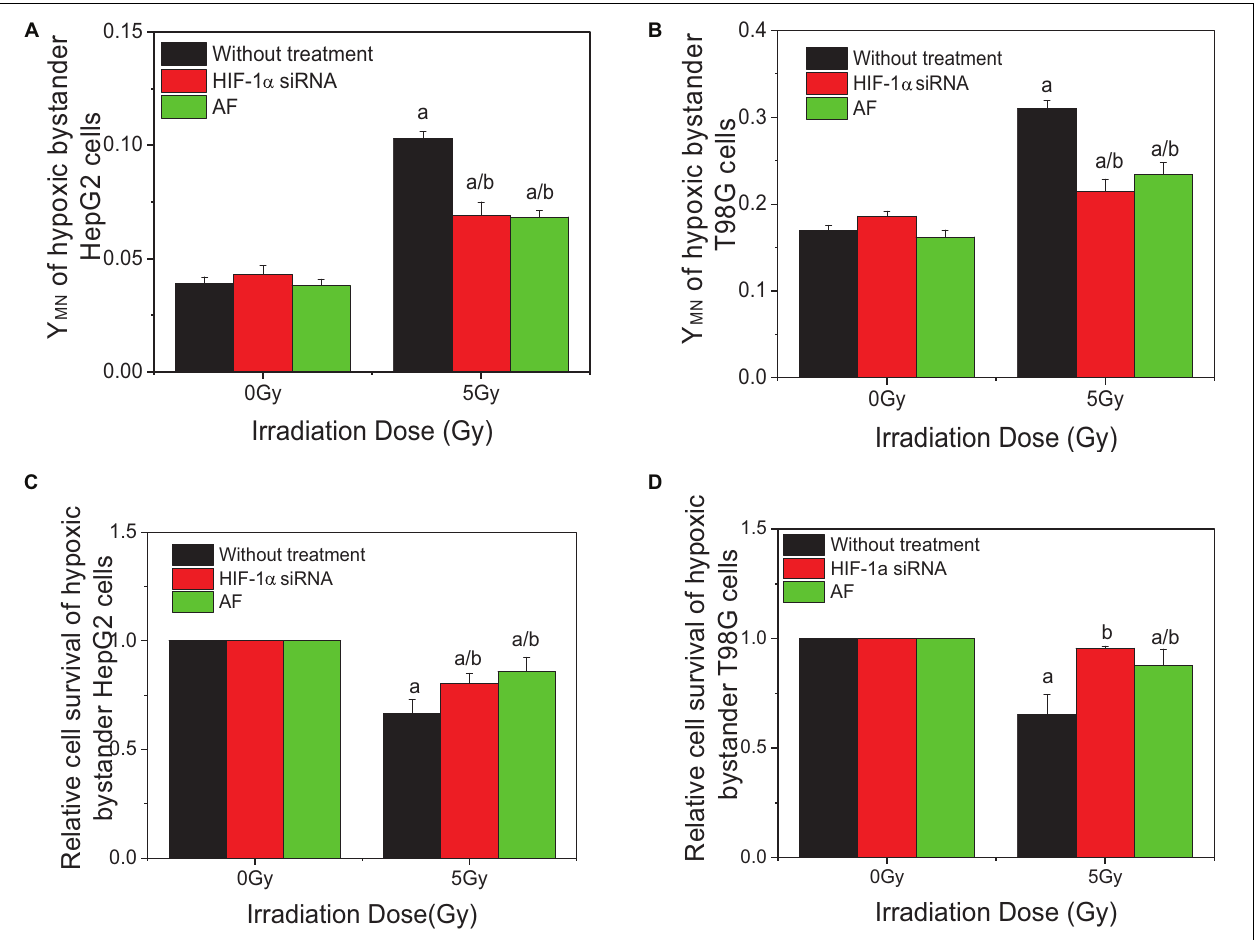
FIGURE 4 | Influence of HIF-1 α on the bystander effect of HepG2 cells and T98G cells under hypoxic conditions. Bystander tumor cells were treated with the conditioned medium harvested from irradiated conspecific cells, which were pretreated with HIF-1 α siRNA and 5 µ M 7-aminoflavone under hypoxic